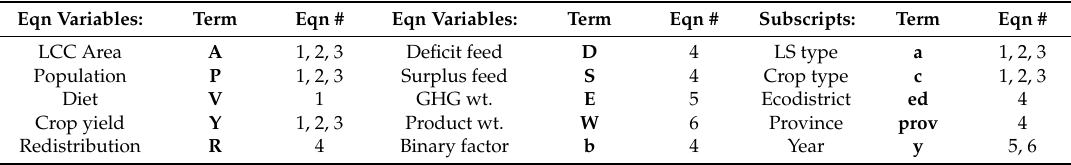
Table 1. Variables, terms and subscripts used in area redistribution calculations and weighted averages, used in each Equation Number (Eqn #) from 1 to